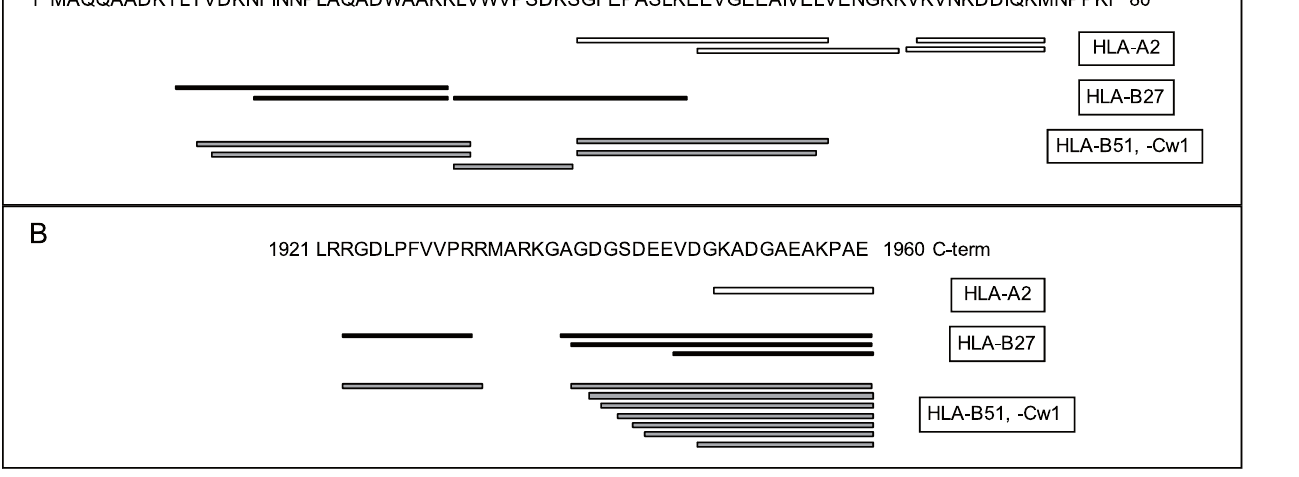
Table 3. HLA restriction and number of proteins from TAP-independent ligands.